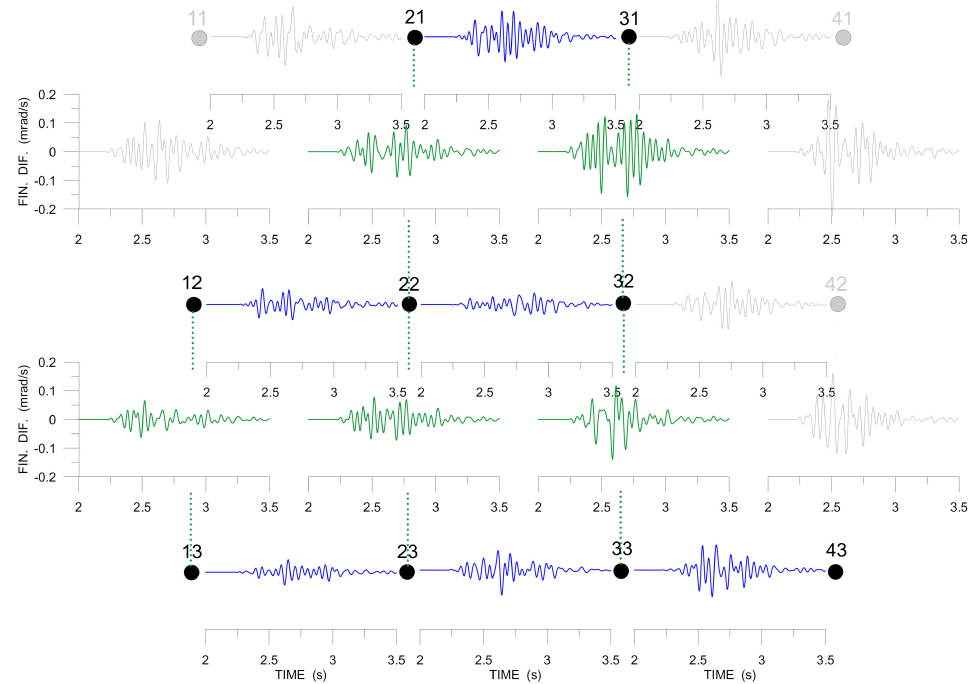
Figure 14. Band-pass filtered (6–20 Hz) finite differences, ∆ v x / ∆ y (blue), ∆ v y / ∆ x (green), x -axis pointing to the North, y -axis pointing to the West. The large dots mark the stations in the array (see Figure 2). The differential seismograms are drawn between the dots corresponding to the stations used to derive them. The data excluded from further processing are shown in